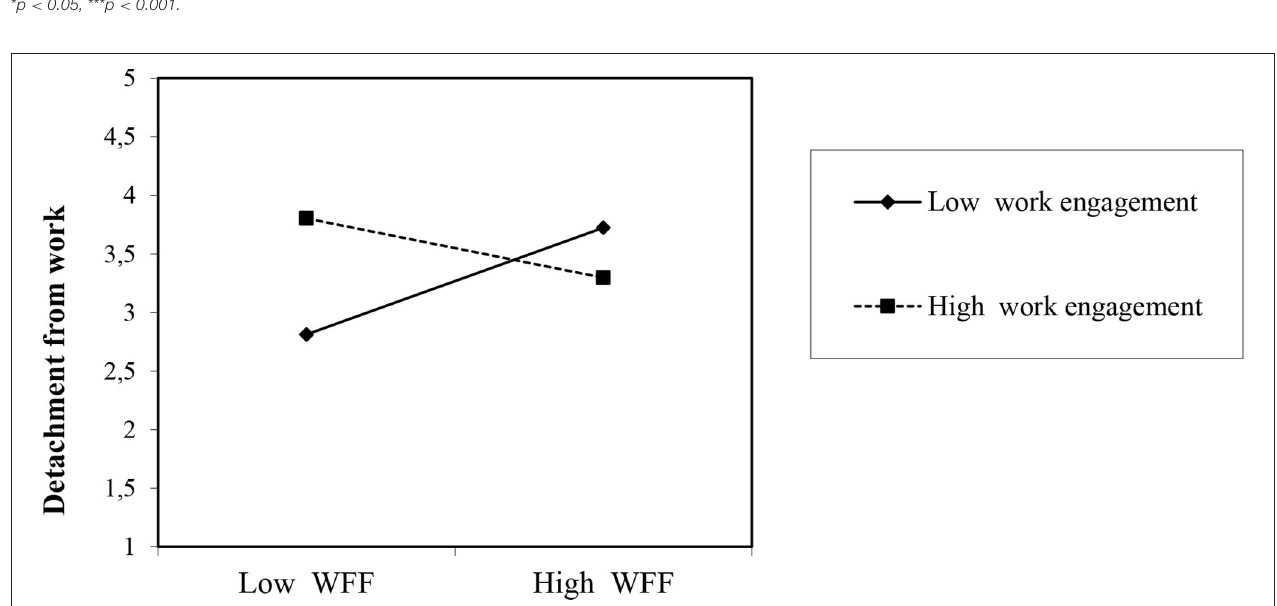
FIGURE 2 | Interaction effects of daily work engagement and day-level of WFF in predicting psychological detachment at night. WFF, Work-Family